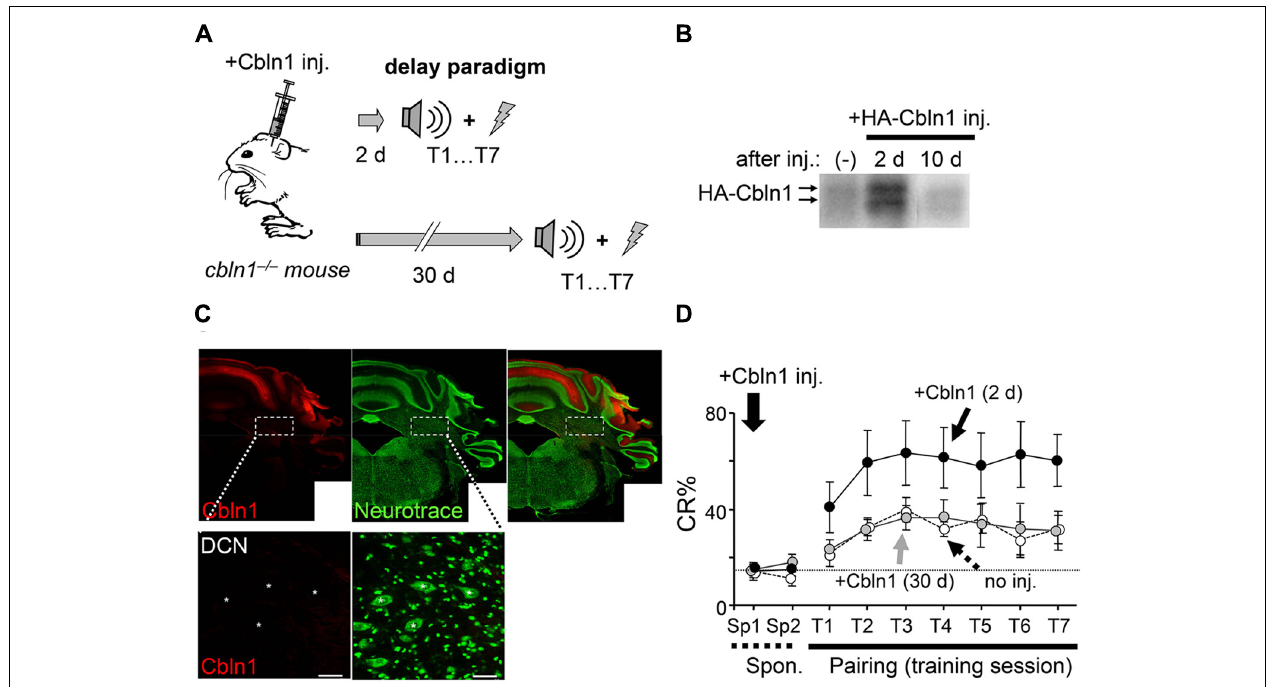
FIGURE 3 | Delay eyeblink conditioning (EBC) in adult cbln1 − / − mice improves after a cerebellar subarachnoid Cbln1 injection. (A) A diagram showing a sequence of experiments. HA-Cbln1 (1 μ g/g body weight) was injected into the subarachnoid spaces over the bilateral HVI lobes of 7- to 10-week-old cbln1 − / − mice. The mice were trained using the delay EBC paradigm beginning 2 or 30 days after the injection. (B) HA-Cbln1 disappears from the cerebellum by 10 d after injection. Immunoblotting with an antibody against HA was used to detect injected HA-Cbln1 in the P2 fraction of the whole cerebellum before ( − ), 2 days, and 10 days after the injection. Arrows indicate bands corresponding to HA-Cbln1. The blot represents results from n = 3 mice. (C) Distribution of injected Cbln1. Cerebellar slices were stained with anti-HA antibody (red) to detect HA-Cbln1 24 h